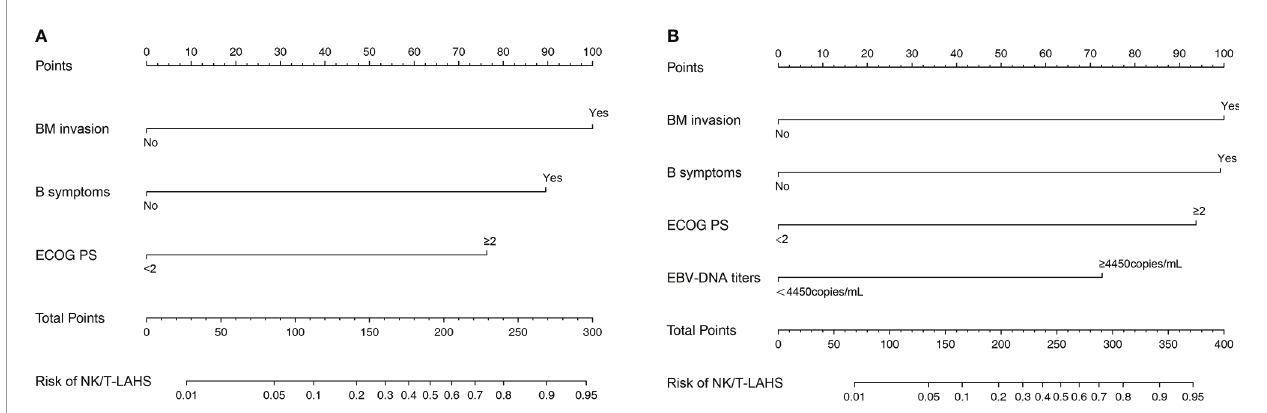
FIGURE 3 | Nomograms to predict the probabilities of hemophagocytic syndrome in patients with nasal-type, extranodal nature killer/T-cell lymphoma: all patients (A) and patients with available Epstein-Barr virus DNA data (B) .